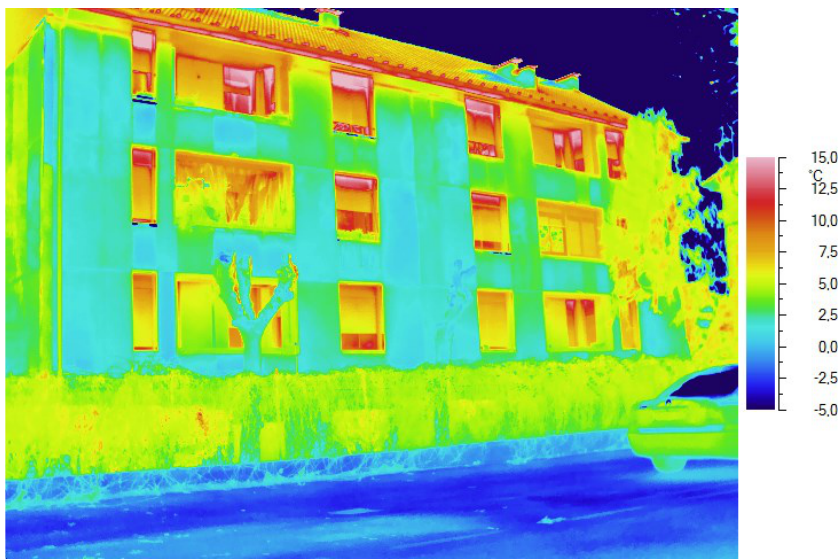
Figure 6. Thermal imaging survey on the north-east façade before retrofitting.